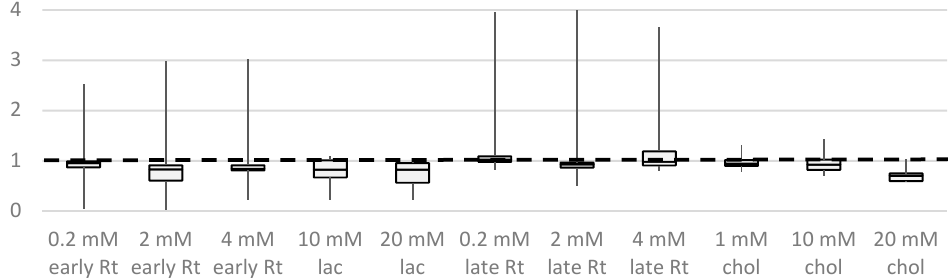
Figure 8. Boxplots illustrating the signal ratio distribution for eight derivatives of intermediate retention (phosphate, erythritol, ribose, ribitol, citric acid, fructose, glucose, and mannitol, each 50 µM) challenged by addition of early and late eluting compounds at the given concentration. Analyzed on a Trace Focus GC using a laminar cup splitter liner.